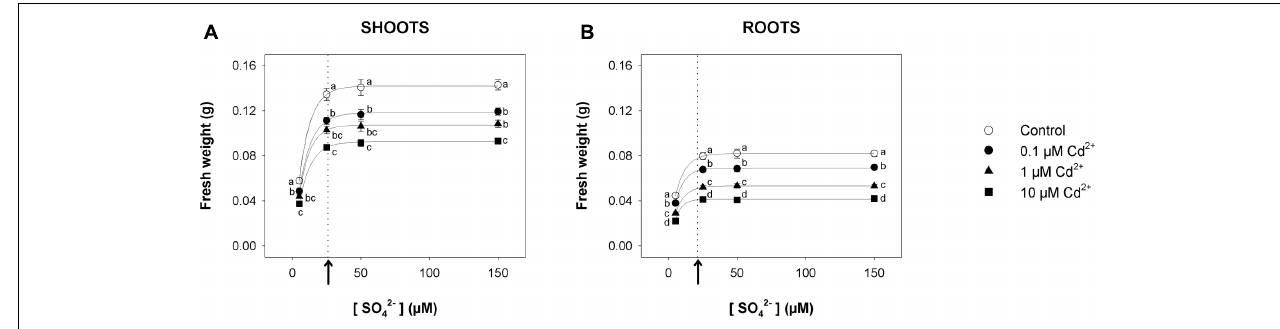
FIGURE 1 | Effect of short-term exposure to Cd on shoot and root growth as a function of the sulfate concentration in the external medium. Arabidopsis plants were pre-grown for 19 days under four sulfate concentrations (5, 25, 50, and 150 µ M) and then exposed for 72 h to three concentrations of Cd 2 + (0.1, 1, and 10 µ M). The characteristic curves describing shoot and root fresh weight accumulation in relation to the external sulfate were drawn by fitting a three-parameter exponential rise to maximum function to the data obtained by weighing the shoot and the roots of the Arabidopsis plants at the end of each experiment. (A) Shoot fresh weight accumulation. The correlation coefficients of the fittings were: 0.999 for the control, and 0.999, 0.999, 0.999 for plants exposed to 0.1, 1, 10 µ M Cd 2 + , respectively. (B) Root fresh weight accumulation. The correlation coefficients of the fittings were: 0.999 for the control, and 0.998, 0.999, 0.996 for plants exposed to 0.1, 1, 10 µ M Cd 2 + , respectively. Data are means and SE of two experiments run in triplicate ( n = 6). Different letters indicate significant differences ( P < 0.05). Dotted lines and arrows indicate [SO 42 − ] crit